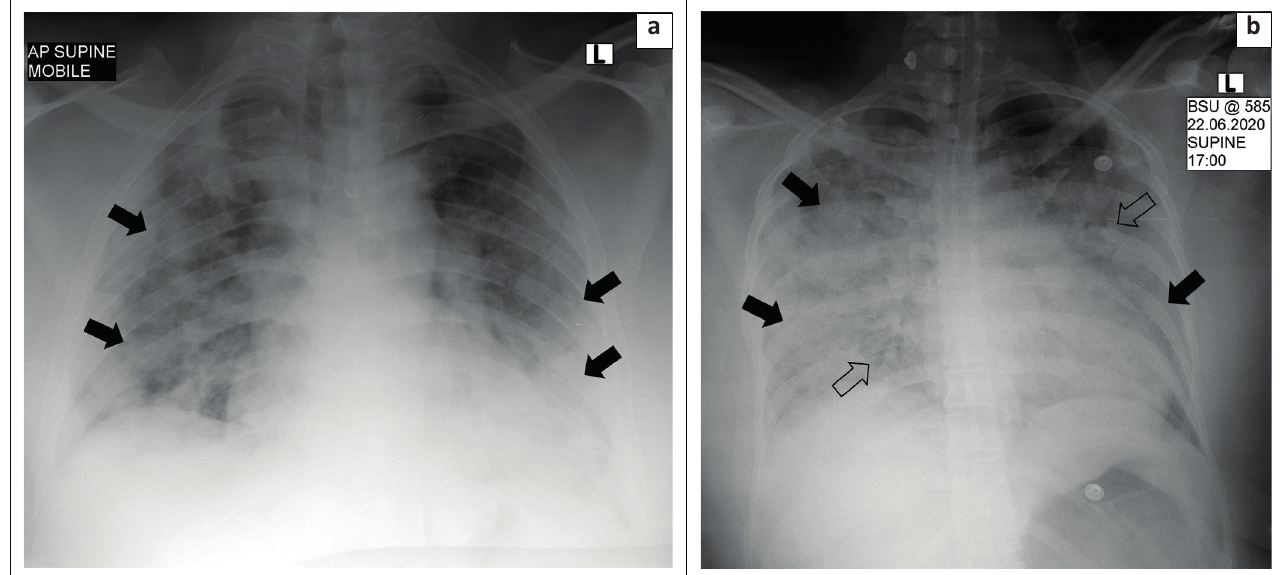
FIGURE 3: (a) Chest radiograph of a 39-year-old man with type 2 diabetes mellitus and hypertension who presented with a cough, dyspnoea and fever. There are typical findings of predominantly peripheral, patchy ground glass opacities bilaterally (black arrows). (b) Chest radiograph of a 48-year-old woman with asthma, hypertension and severe COVID-19 pneumonia. Bilateral, multi-zonal, patchy, ground glass opacities (black arrows) and consolidation with air bronchograms (open arrows).